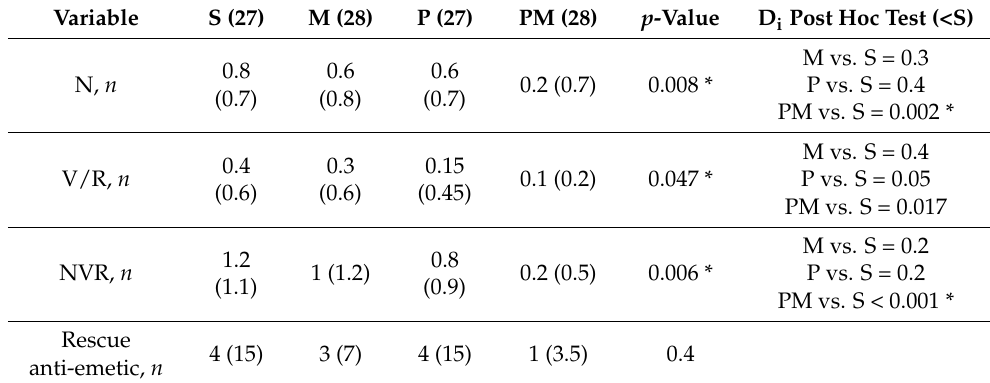
Table 3. Mean episodes of NVR after